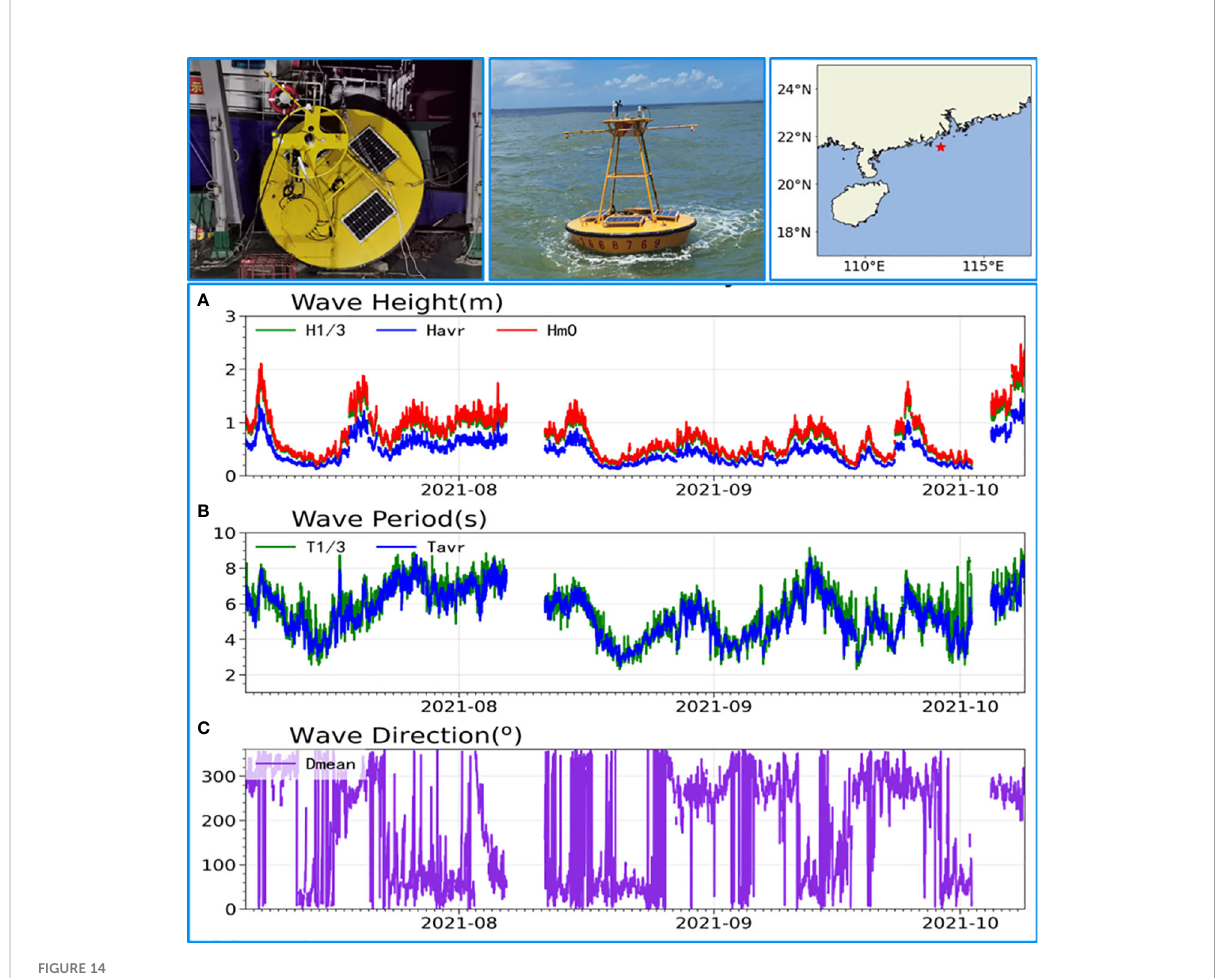
FIGURE 14 Wave observation in